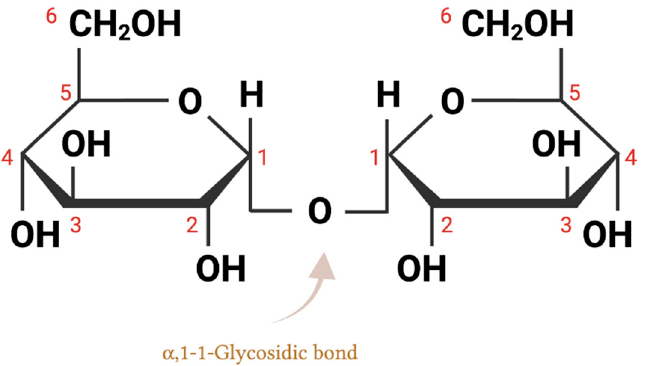
Figure 1. Structural illustration of trehalose, a disaccharide formed by combining two glucose molecules with an α -1,1 glycosidic linkage ( α -D-glucopyranosyl-1,1- α